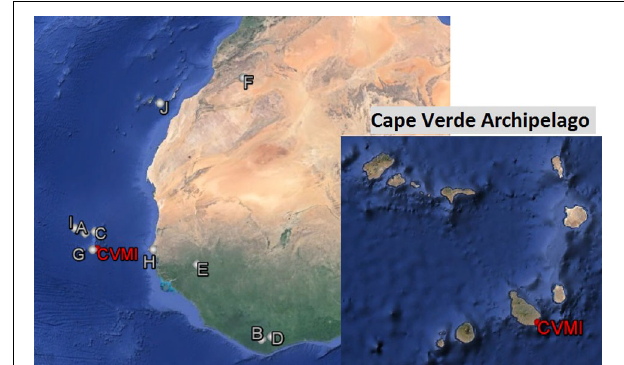
FIGURE 5 | Map of sampling site (CVMI—Cape Verde Meteorological Institute) in the isle of Santiago, Cape Verde archipelago, off-shore of the North-west Africa coast. Letters from A to J show sampling sites of previous sampling campaigns referred and discussed in the text: A, Chiapello et al. (1997); B, Afeti and Resch (2000); C, Caquineau et al. (2002); D, Sunnu et al. (2008); E, Rajot et al. (2008); F, Kandler et al. (2009); G, Kandler et al. (2011b); H, Flament et al. (2011); I, Rodriguez et al. (2011); J, Gelado-Caballero et al. (2012).